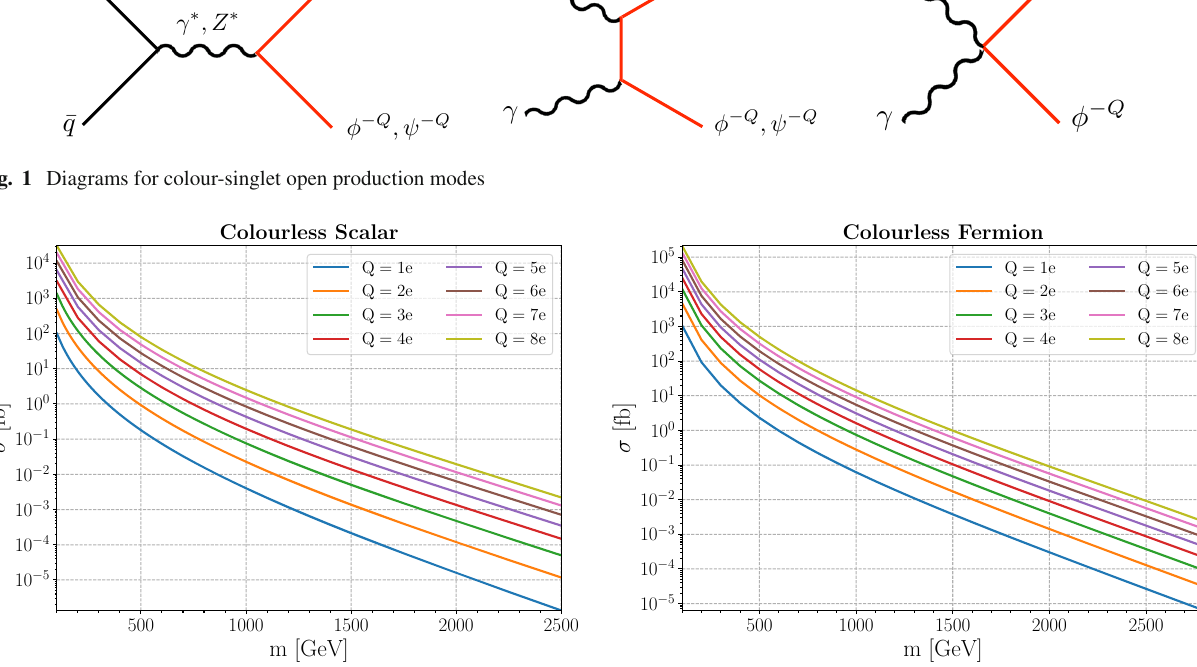
Fig. 2 Pair-production cross section for colourless scalars (left) and fermions (right). Lines with different colours correspond to particles with electric charges from 1 to 8 times the elementary charge